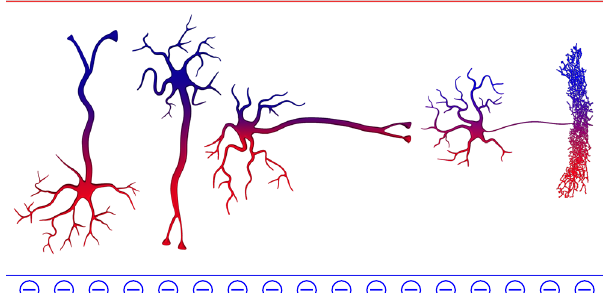
Fig. 1 The impact of orientation of neuronal compartments on TES-induced excitability. Four idealized neurons are shown with different orientation relative to the induced electric fi eld. The electric fi eld can affect the soma, dendrites, axon initial segment and the axon tree differently. The relationship between the electric fi eld vector and the morphology/ orientation of neurons and individual neuronal compartments determine whether the neuron will be net depolarized or hyperpolarized